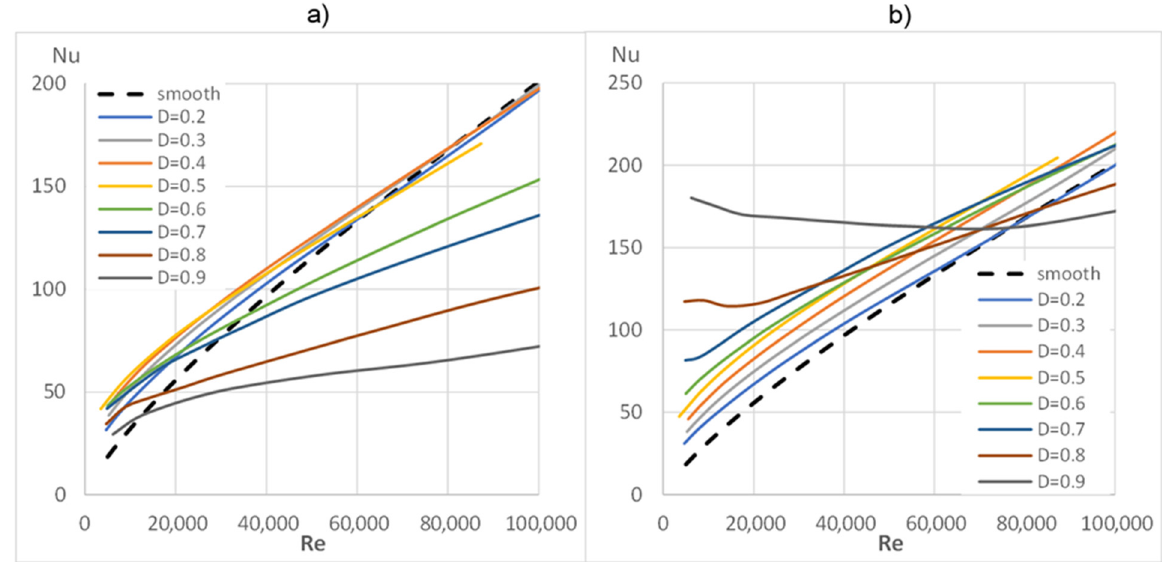
Figure 11. Nusselt number Nu ( Re ) as a function of Re number, calculated on the basis of the average temperature: ( a ) from the entire pipe; ( b ) from the annular section of pipe.